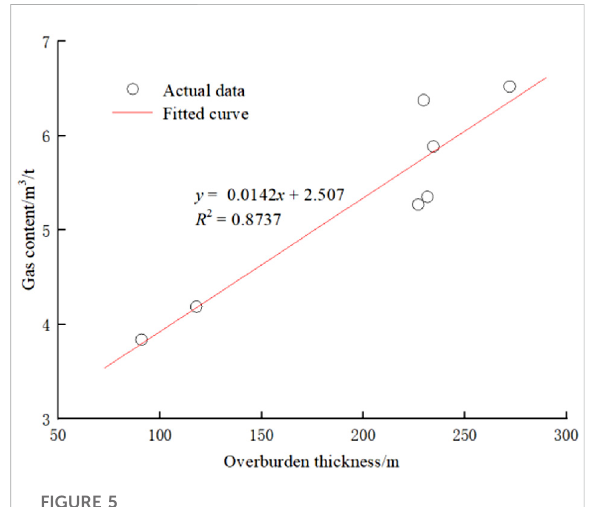
FIGURE 4 Gas content scatter with fi tting curve with the increased buried depth in district #2.